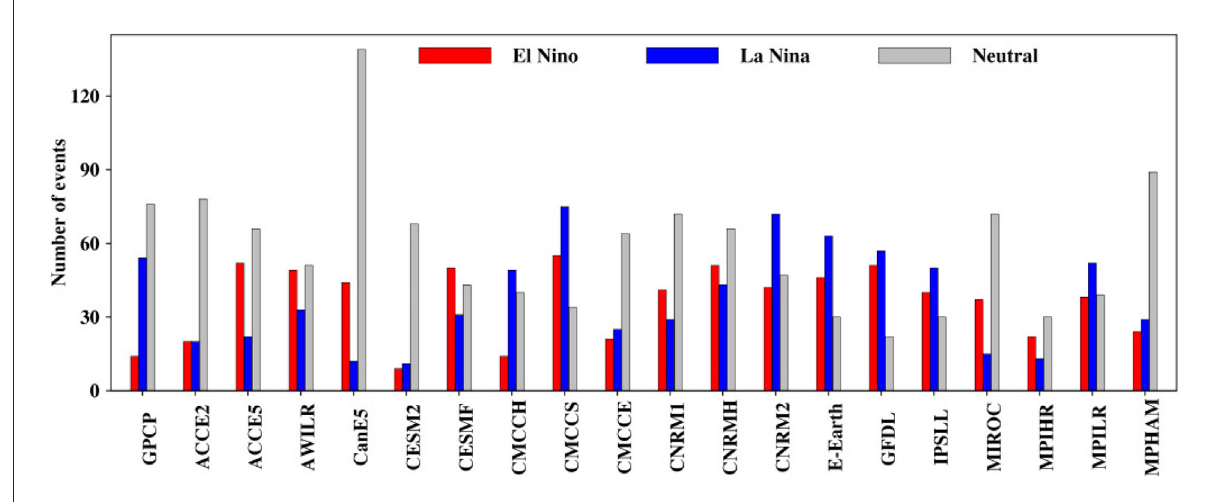
FIGURE5 Number of days of dry extreme rainfall events for ENSO phases during inactive BSISO.